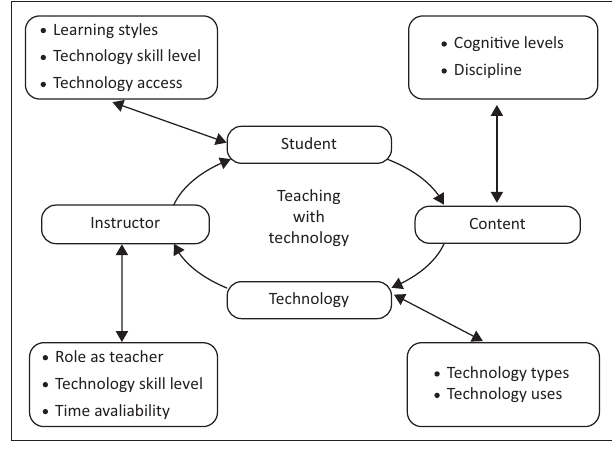
FIGURE 1: A model for teaching with